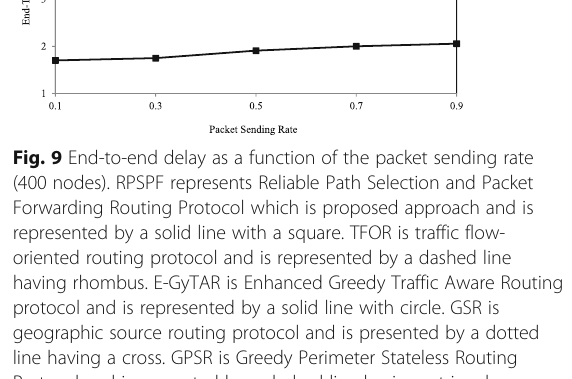
Fig. 10. An increase in traffic density increases routing overhead for all the protocols. This is because the num- ber of control messages produced during simulation is directly proportional to the number of vehicles. The routing overhead incurred by RPSPF is least as com- pared to the other routing protocol. For acquiring neigh- bor locations, GSR produces more beacon messages which increase its routing overhead. The number of bea- con messages generated by GSR is three times more as compared to E-GyTAR [1]. GPSR recovery strategy incurs more packet transmission which induces higher